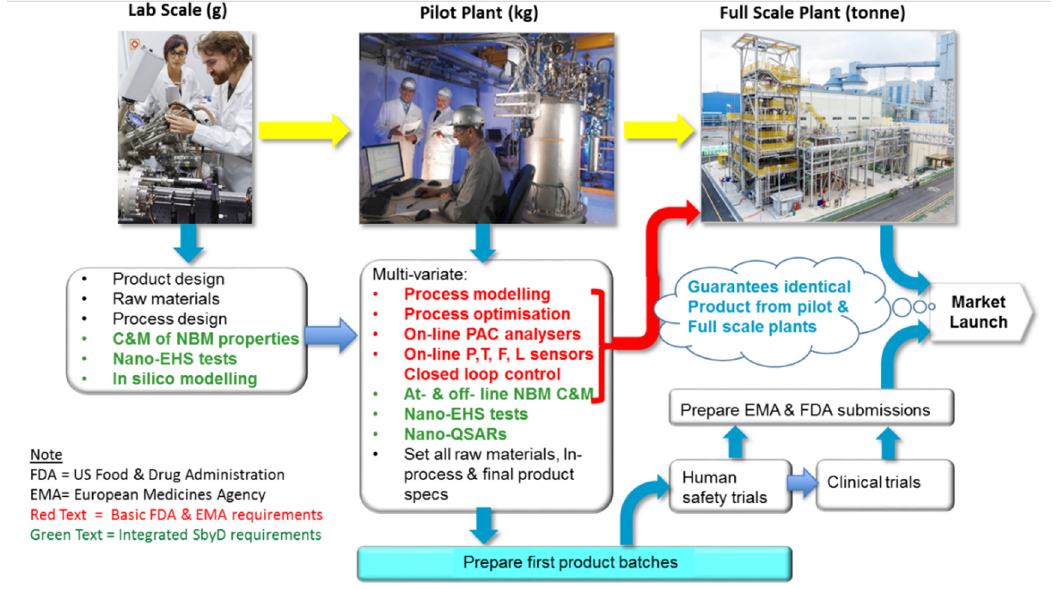
Figure 3. Integration of risk management framework into FDA/EMA 2003 Process Analytical Control Regulations for ATMPs (P = pressure, T = temperature, F = flow, L = level, PAC = process analytical control).